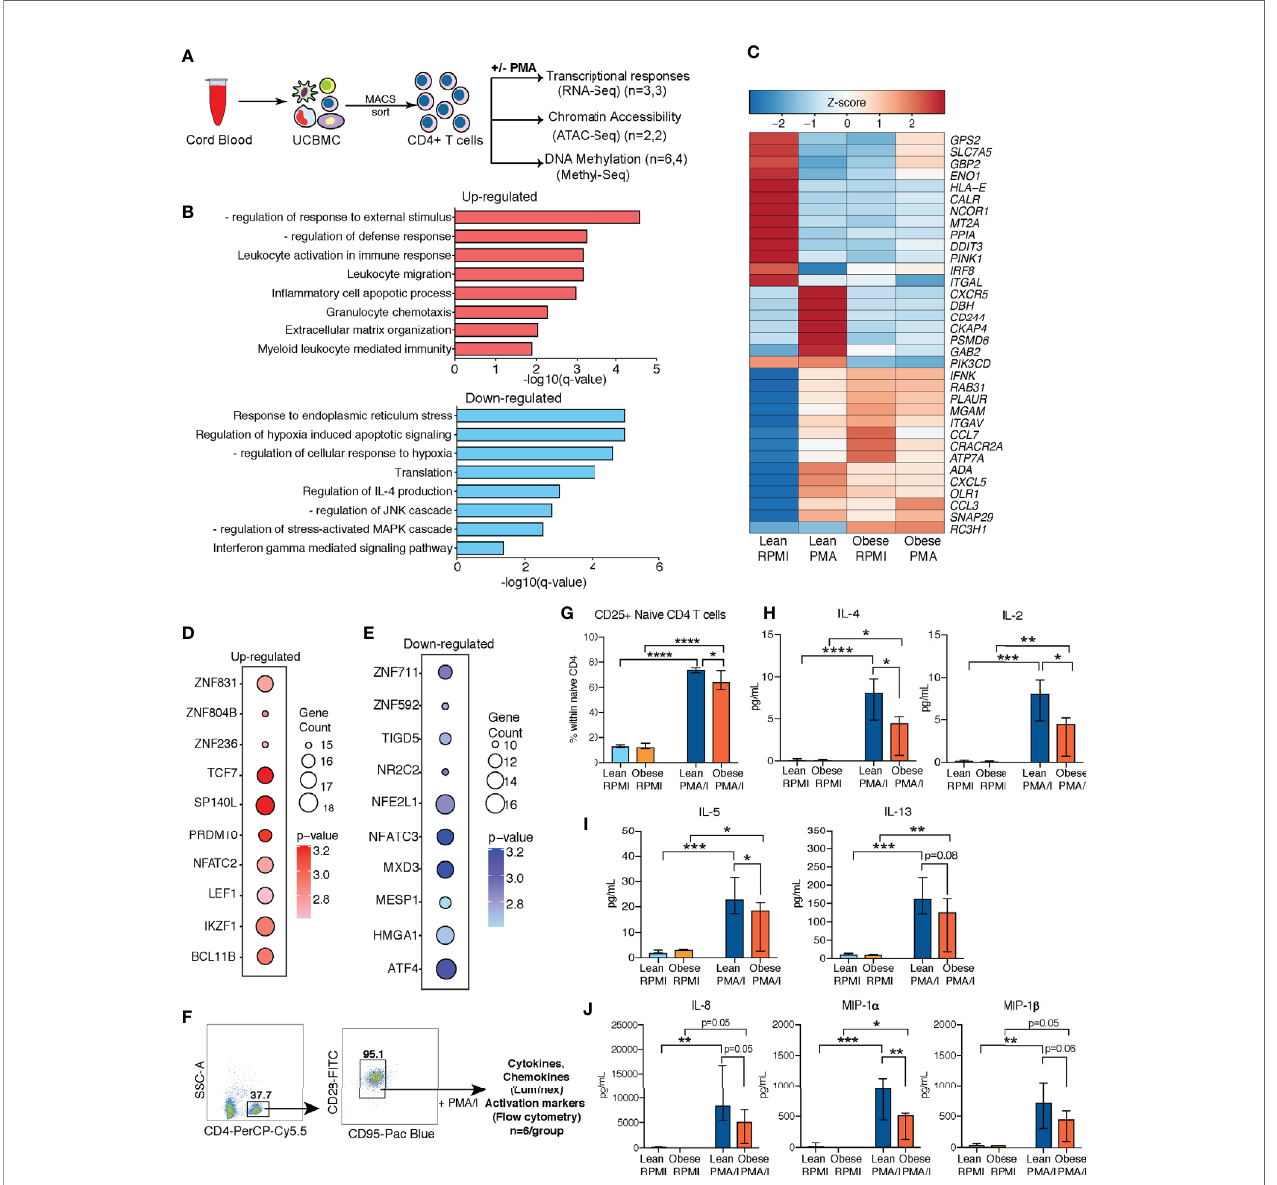
FIGURE 3 | Cell intrinsic defects in cord blood CD4 T cells with maternal obesity. (A) Experimental design for testing impact of maternal pregravid obesity on cord blood CD4+ T cells. CD4 T cells were magnetically isolated from UCBMC using MACS and subjected to ATAC-Seq, and MethylSeq (number of samples/group indicated in legend). Puri fi ed CD4 T cells were also stimulated with PMA/Ionomycin overnight or left unstimulated. Response was assessed using bulk RNA sequencing. (B) Bar graphs offunctional enrichment of upregulated (top) and downregulated (bottom) DEG in UCB CD4+ T cells from the lean group following PMA/Ionomycin identi fi ed by Metascape. (C) Heatmap of representative DEGs detected in UCB CD4 T cells from the lean group that enriched to GO terms “ leukocyte activation ” and “ leukocyte migration ” , and “ response to ER stress ” . (D, E) Bubble plots representing TFs regulating (D) upregulated (left) and (E) downregulated (right) DEG in lean group following PMA stimulation. Size of the bubble represents number of genes and intensity of color represents statistical signi fi cance. (F) Gating strategy for FACS sorting naïve CD4 T cells from UCBMC. Sorted cells were stimulated with PMA/Ionomycin overnight. Secreted proteins were measured using luminex and T cell activation measured using fl ow cytometry (n=6/group). (G) Relative proportions of naïve CD4 T cells expressing T cell activation marker CD25. (H – J) Secreted levels of (H) IL-4 and IL-2; (I) IL-5 and IL-13), and (J) chemokines IL-8, MIP-1 a , and MIP-1 b following overnight PMA/I stimulation of naïve CD4 T cells from umbilical cord. Error bars represent median with interquartile ranges. (Ordinary one-way ANOVA p-values: * - p < 0.05; ** - p < 0.01; *** - p < 0.001; **** - p <